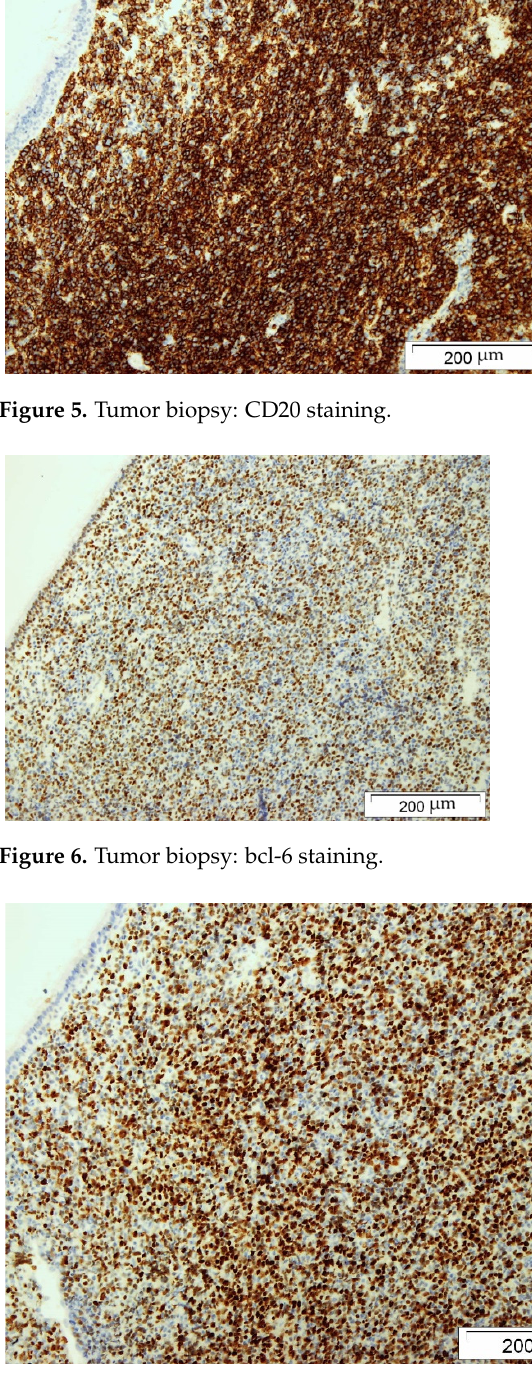
Figure 7. Tumor biopsy: MUM ‐ 1 staining.